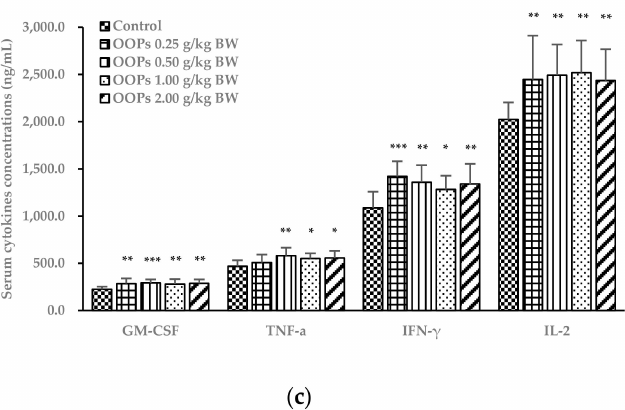
Figure 4. E ff ects of OOPs on cytokine concentrations in serum. ( a ) Interleukins (IL)-6 and IL-10 concentrations in serum; ( b ) IL-12 and IL-1 α concentrations in serum; ( c ) granulocyte-macrophage colony-stimulating factor (GM-CSF), tumor necrosis factor- α (TNF- α ), interferon- γ (IFN- γ ) and IL-2 concentrations in serum. Data are represented as mean ± SD, n = 10. * p < 0.05 vs. control group, ** p < 0.01 vs. control group, *** p < 0.001 vs. control group.